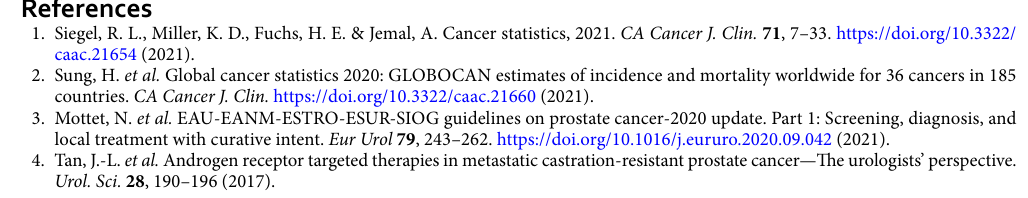
Figure 4. Pharmacodynamic changes in ctDNA fraction, pTMB and total alteration counts in response to chemotherapy. Comparisons were made in patients who were classified for response to chemotherapy on the basis of PSA levels at the time of second sample collection following 3–4 cycles of treatment. Patients exhibiting stable or decreased PSA levels were classified as “PSA Stable/Decrease” and those exhibiting increased PSA levels as “PSA Non-Responders”. ( a ) Median ctDNA fraction ( p = 0.001) and pTMB ( p = 0.004) were significantly reduced in the group of combined patients (n = 29) after 3–4 cycles of docetaxel. ( b ) Similar significant reductions in ctDNA fraction were observed for the “PSA Stable/Decrease” patients (n = 17, p = 0.03) and the “PSA Non-Responder” patients (n = 12, p = 0.03). ( c ) Median pTMB was significantly reduced in the “PSA Stable/Decrease” patients ( p = 0.001) but not the “PSA Non-Responder” patients ( p = 0.91). ( d ) Similar reductions were observed in median total alteration counts for the “PSA Stable/Decrease” patients ( p = 0.03) and the “PSA Non-Responder” patients ( p = 0.06). When this comparison was restricted to the top 32 most altered genes, values were significantly reduced in the “PSA Stable/Decrease” patients ( p = 0.007), and modestly in the “PSA Non-Responder” patients ( p = 0.08). Comparisons were made using the paired Wilcoxon test with significance set at p ≤